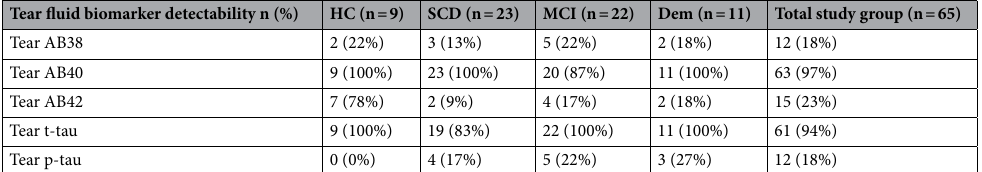
Table 2. Detectability. Number (n) and percentage (%) of tear fluid samples with biomarkers above the LLOD.